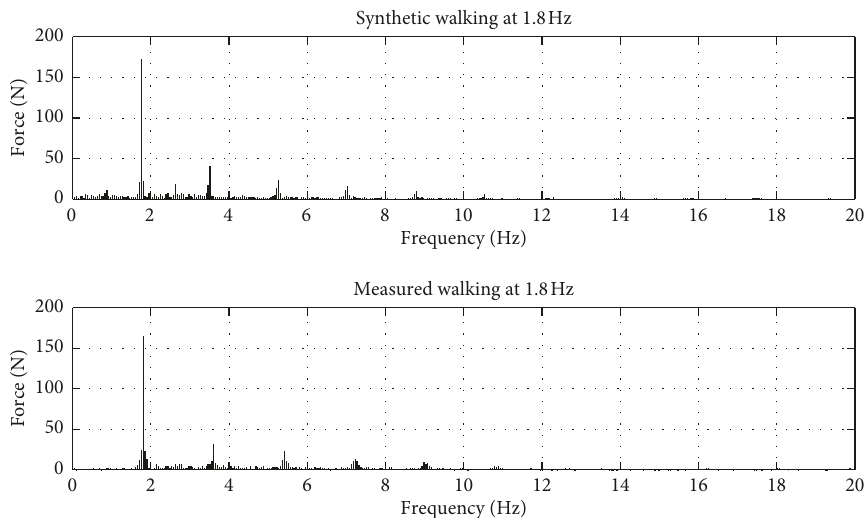
Synthetic walking at 1.8Hz